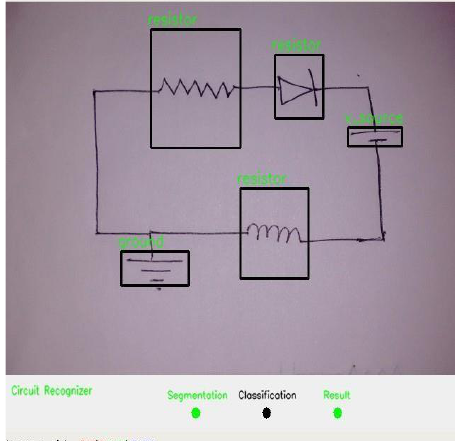
Fig. 4: Diode and Inductor detected as Resistor